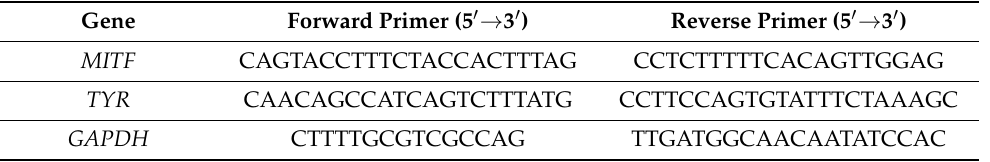
Table 1. Nucleotide sequences of primers used in RT-qPCR analysis. Gene Forward Primer (5 (cid:48) → 3 (cid:48)